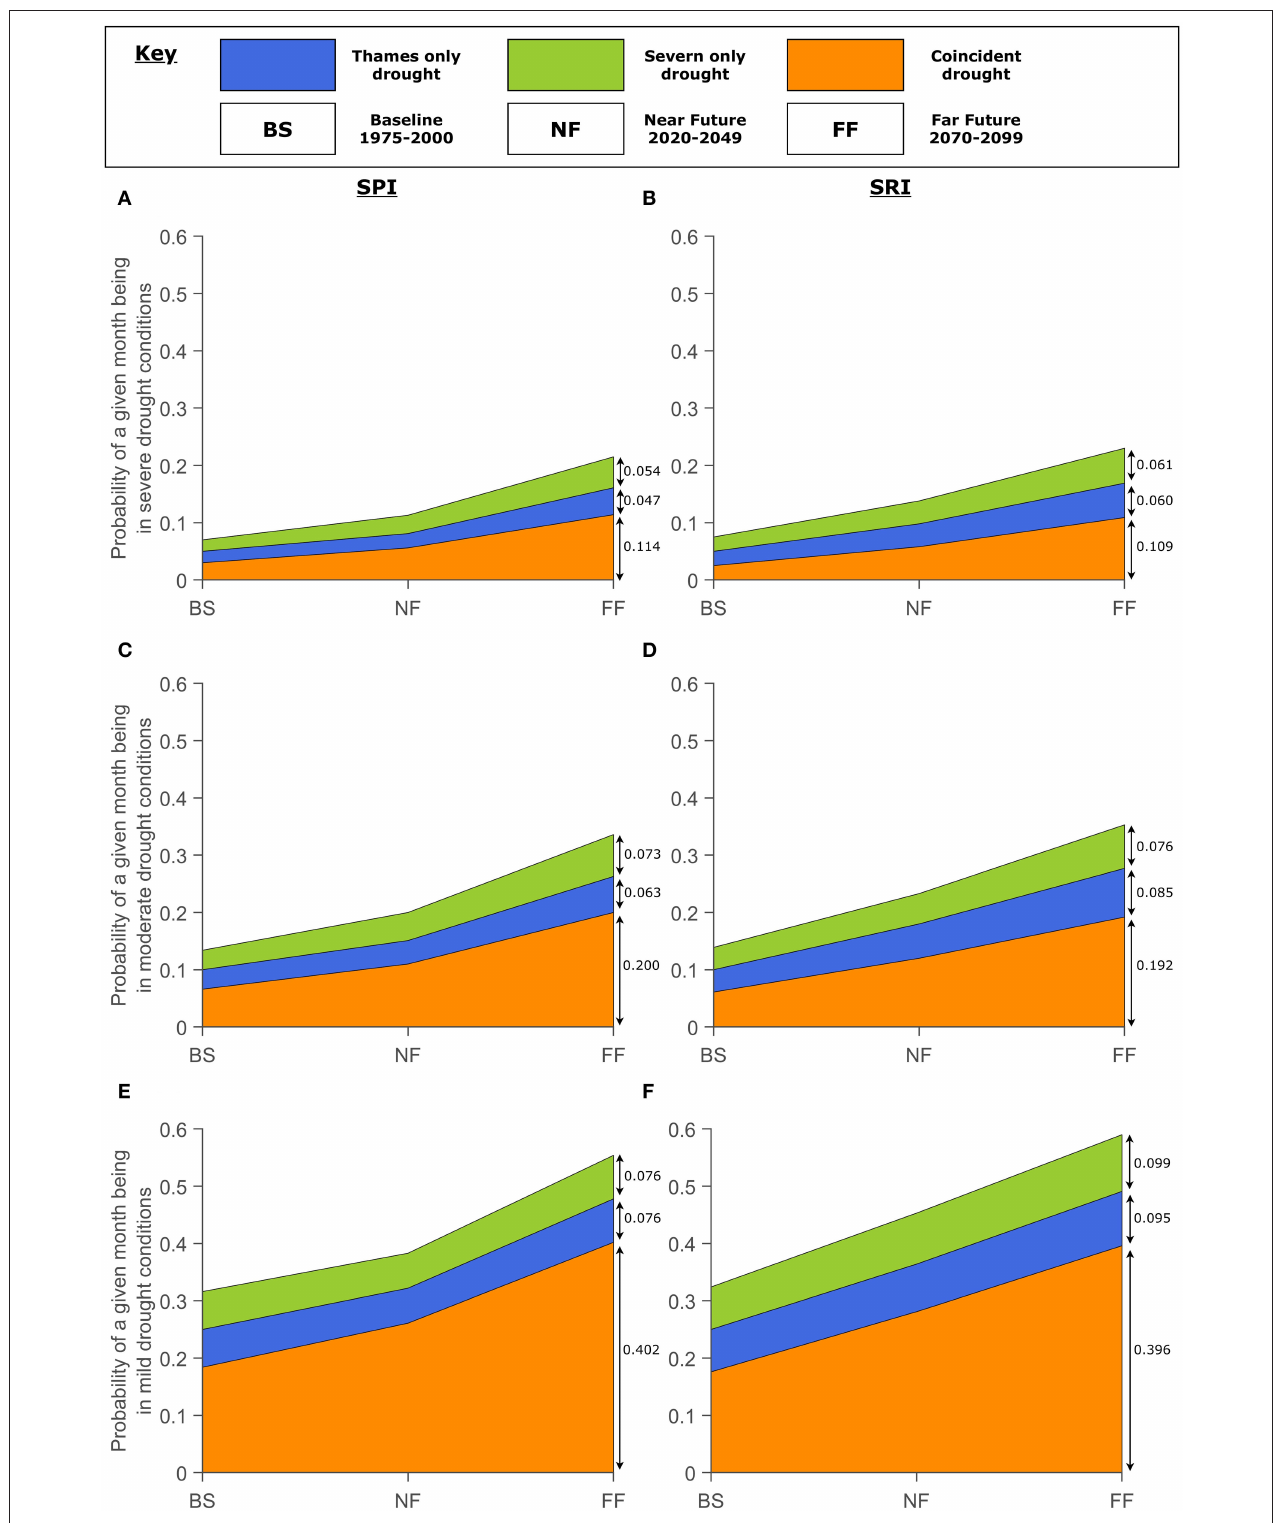
FIGURE 4 | Stacked bar graph showing probability of coincidental and non-coincidental metrological (A,C,E) and hydrological (B,D,F) drought events of different severities occurring throughout the W@H future.